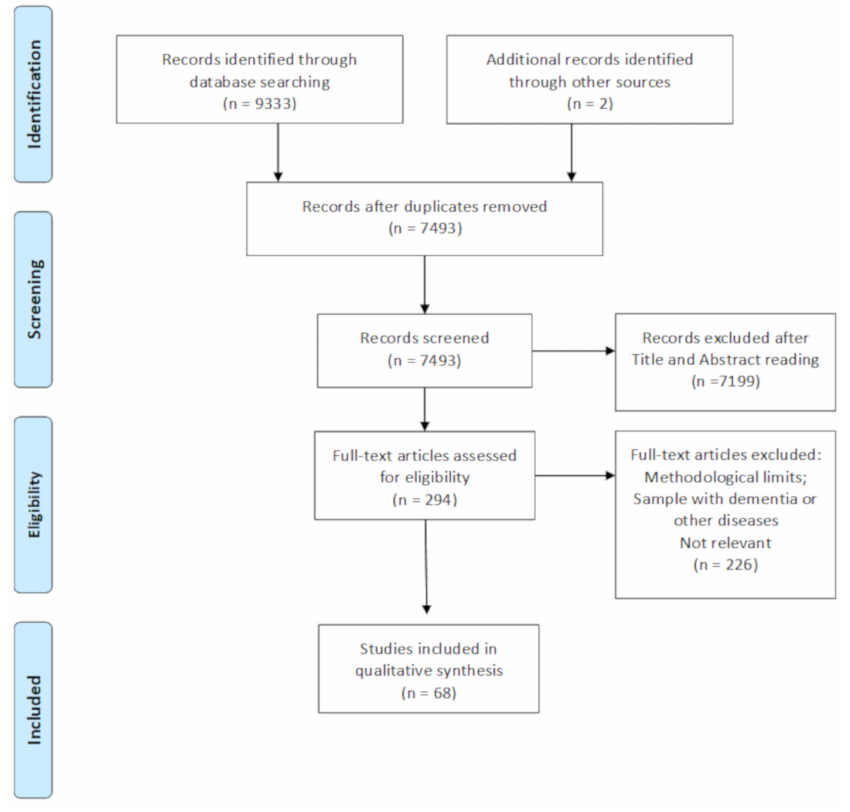
Figure 1. PRISMA flow chart of the selected studies on blood pressure and cognitive